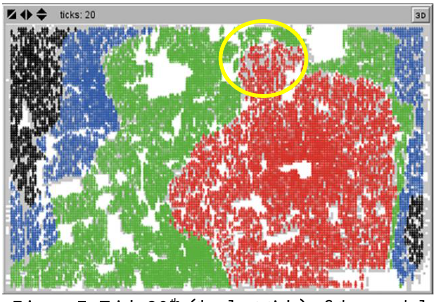
Figure 7: Tick 20 th (the last tick) of the model